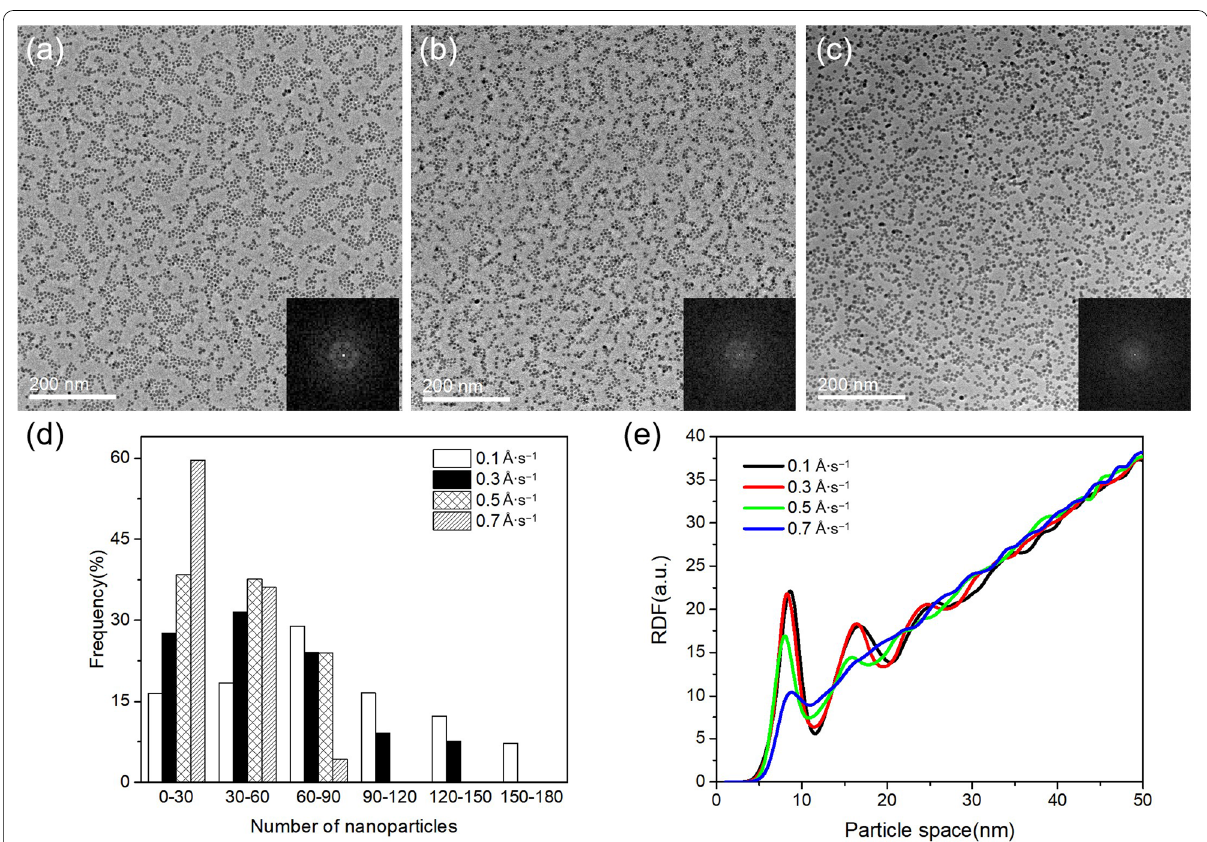
Fig. 3 TEM images of Fe nanoparticle arrays with different deposition rates: a 0.3 Å s − 1 , b 0.5 Å s − 1 , c 0.7 Å s − 1 . The insets show the fast Fourier transform of each spatial distribution. d Histograms of nanoparticle numbers contained within an individual monolayer domain in the nanoparticle arrays deposited with different deposition rates. The average nanoparticle numbers within an individual monolayer domain are counted to 77, 55, 39, and 27 for deposition rates of 0.1 Å s − 1 , 0.3 Å s − 1 , 0.5 Å s − 1 , and 0.7 Å s − 1 , respectively. e Radial distribution function of the Fe nanoparticle arrays with different deposition